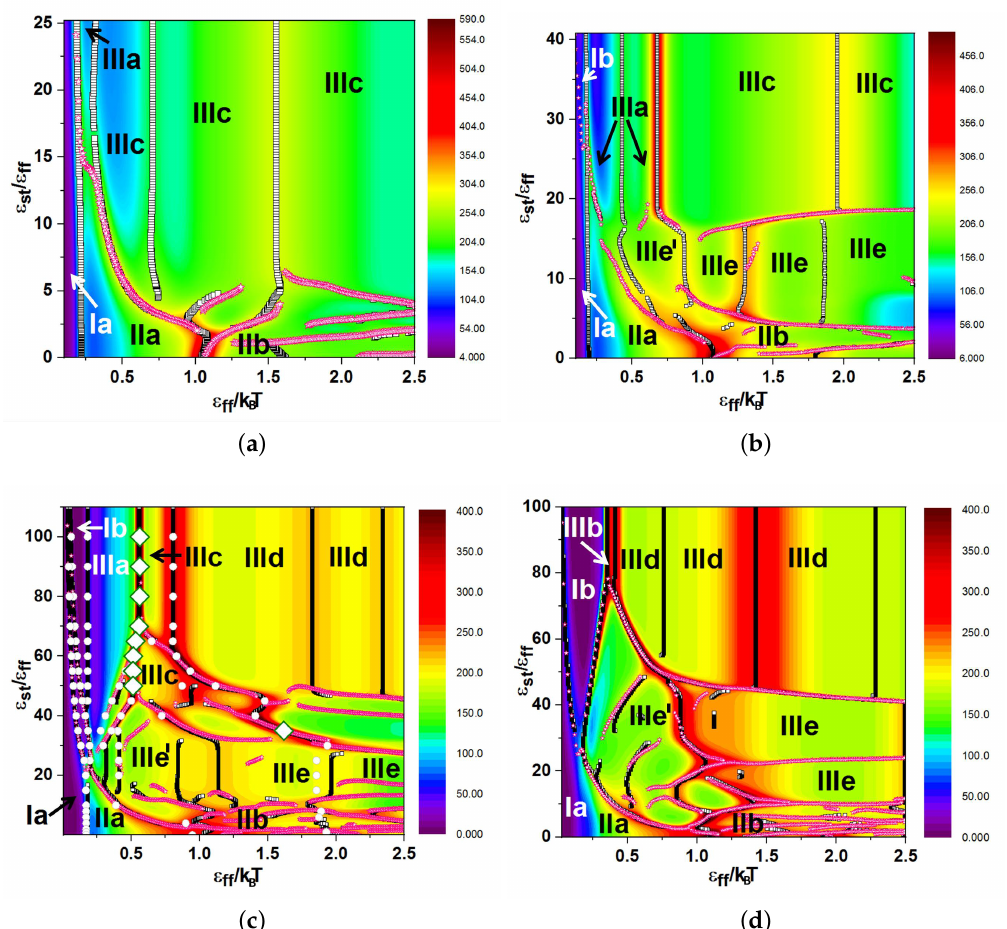
Figure 7. Diagrams of states for the case “S-attract-stronger” for a chain of length N = 64 and block lengths ( a ) b = 4, ( b ) b = 8, ( c ) b = 16, and ( d ) b = 32. The colors encode the specific heat values. The numbers denote the following morphologies: I: coil (blocks of both types are coils, Ia, and F-blocks are coils while S-blocks are extended, Ib); IIa: liquid isotropic globule; IIb: frozen isotropic globule; IIIa: dumbbell globule; IIIb: “tennis racket”; IIIc: “lamellar” globule with no folds in S-blocks; IIId: Saturn-like globule; IIIe: lamellar globule with folds in S-blocks. Open squares indicate maxima in the dependencies of C V ( T ) at fixed values of ε st ; open stars with magenta contour lines indicate maxima in the dependencies of C V ( ε st ) at fixed values of T . Large open rhombs with a thick green contour line and white circles in (c) indicate the results of microcanonical analysis (see the text). Snapshots of selected conformations are shown in Figure